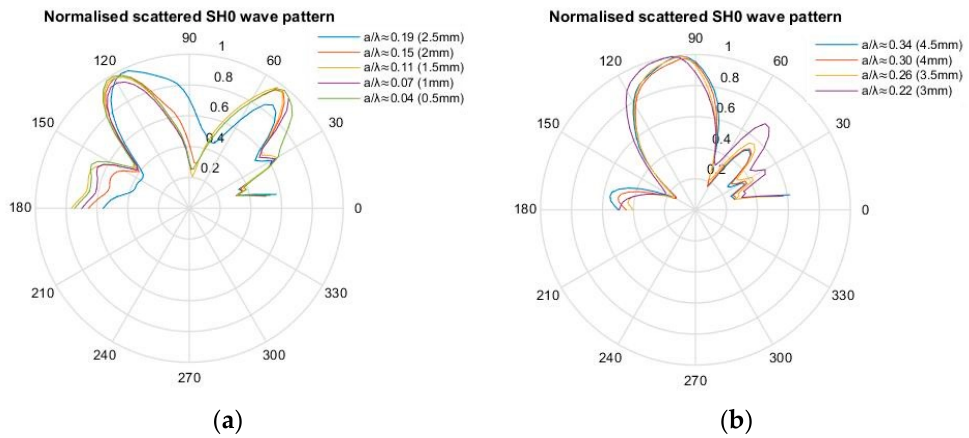
Figure 7. FE-normalised scattered wave polar plot of SH0 waves with respect to the incident wave maximum displacement. ( a ) 0.04 ≤ a/ λ ≤ 0.19; ( b ) 0.22 ≤ a/ λ ≤ 0.34.